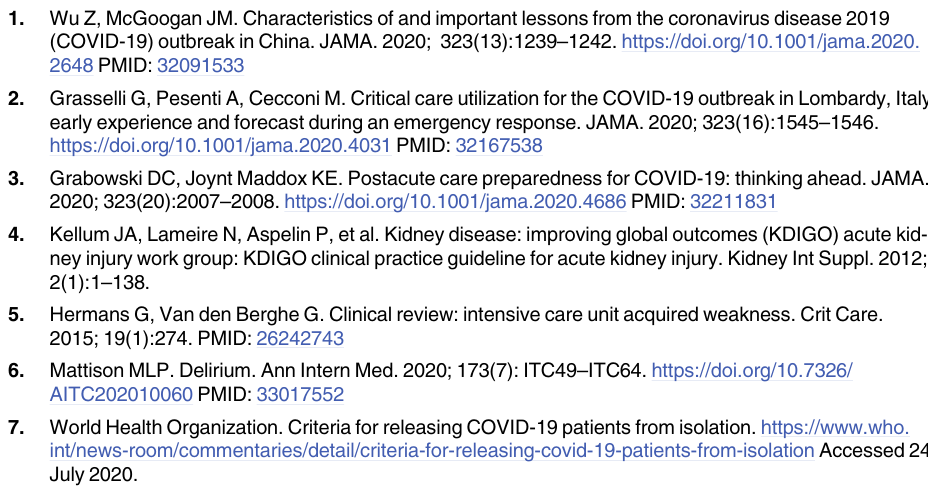
S1 Table. Characteristics of adult patients transferred from critical care units to general medical ward. S2 Table. Demographics of patients transferred from critical care units to general medical ward and all COVID-19 critical care patients. S3 Table. Comparison of characteristics of COVID-19 survivors and deaths. S4 Table. Post-infectious and post-acute complications of COVID-19patients transferred out of critical care